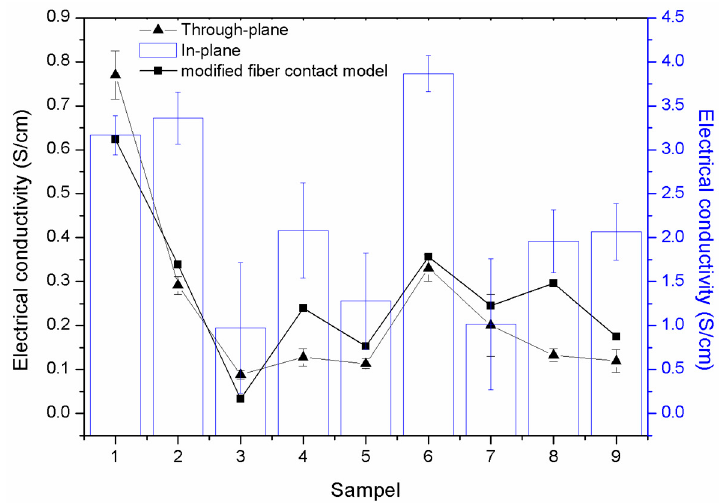
Figure 6. Conductivity (in-plane and through-plane) and predicted electrical conductivity model prediction using modified fibre contact model.